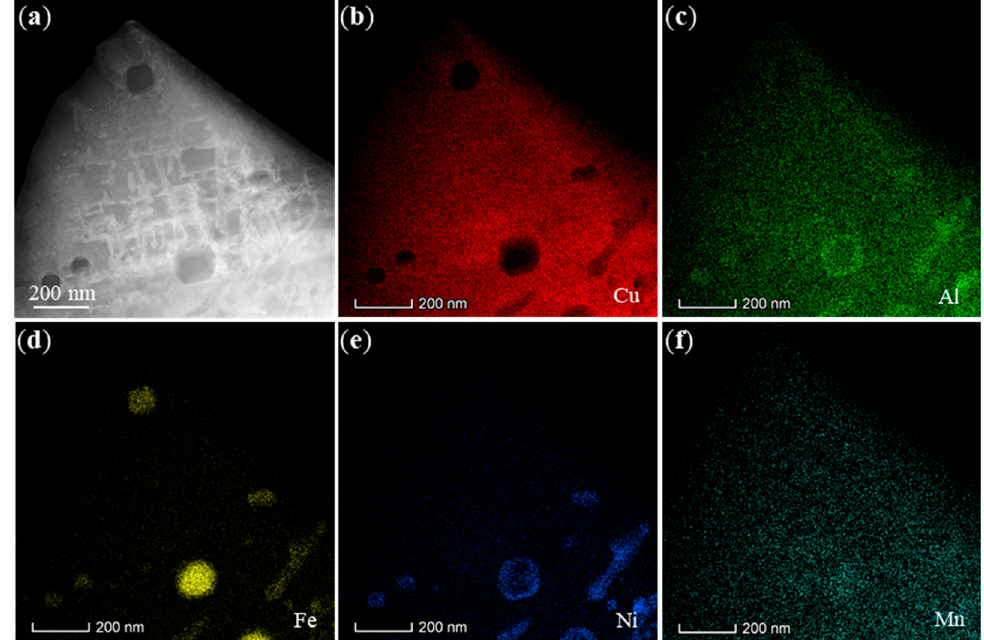
Figure 13. ( a ) HAADF image of the UVA treatment WAAM in the dislocations region, ( b – f ) corresponding EDS elemental maps for Cu, Al, Fe, Ni, and Mn, respectively. The lamellar precipitates are NiAl ( κ III ), and globular Fe 3 Al ( κ II ).